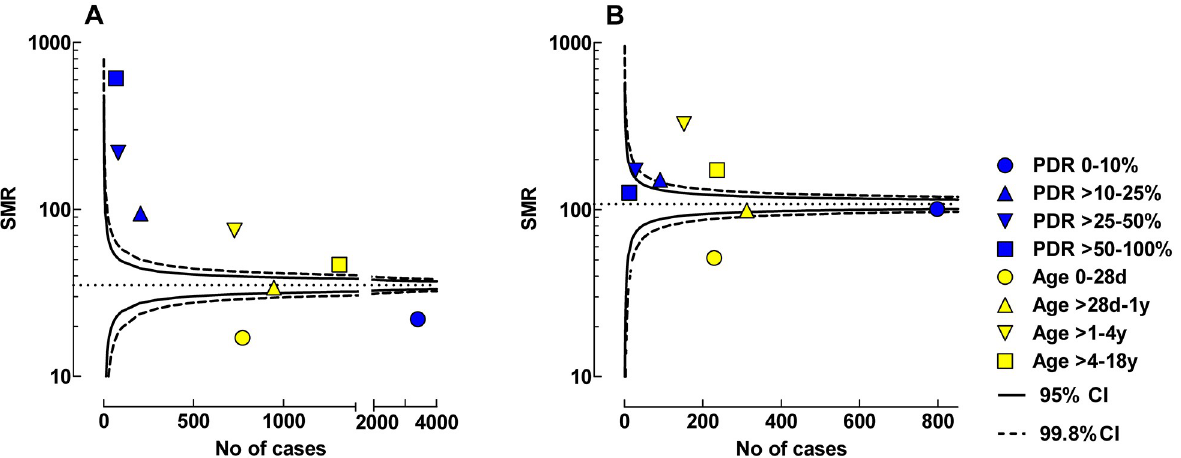
Fig 4. Funnel plots showing SMR for different age and risk stratification groups. The presented data are from the first admission to the PICU. A: Single admission to PICU. B: Repeated admissions to PICU. The 95 and 99.8% confidence intervals of SMR of the entire study population, in relation to number of cases, are given by the solid and dotted lines, respectively.